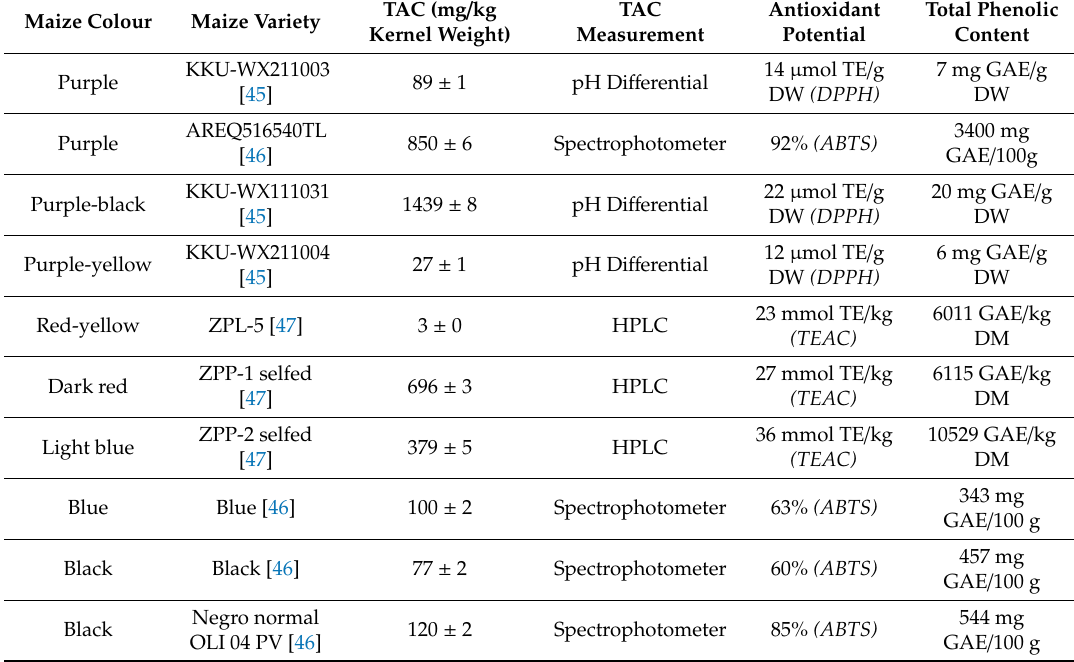
Table 3. Selection of studies focusing on total anthocyanin content (TAC) in various maize cultivars. The anthocyanin quantification method and assay used for antioxidant potential are also listed. Maize